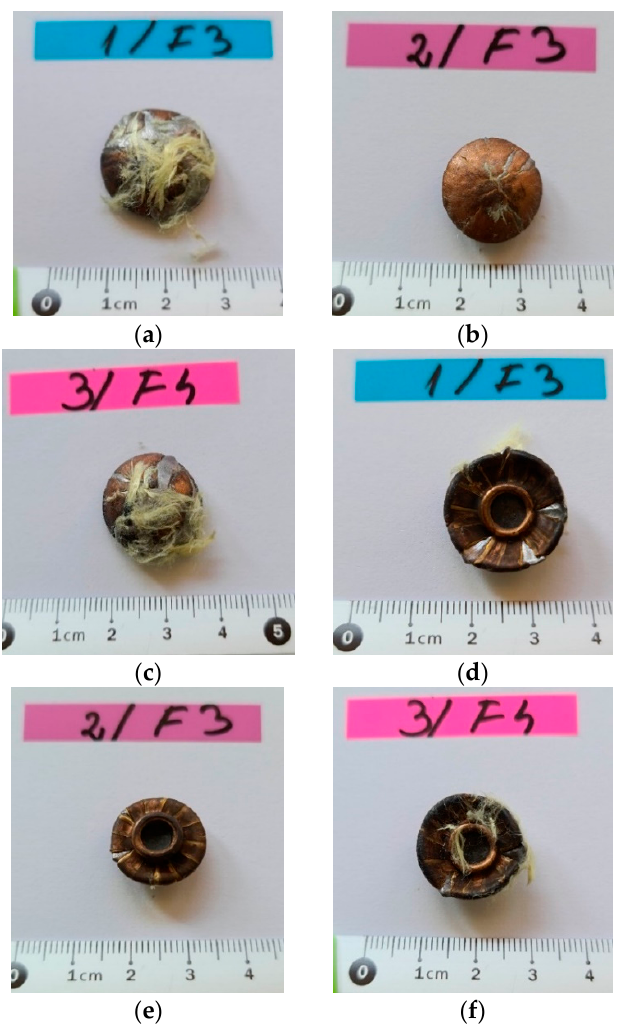
Figure 17. Bullets (9 mm FMJ) as recovered after testing 12-layer ballistic package: front view of the bullets ( a – c ); back view of the same bullets ( d – f ).